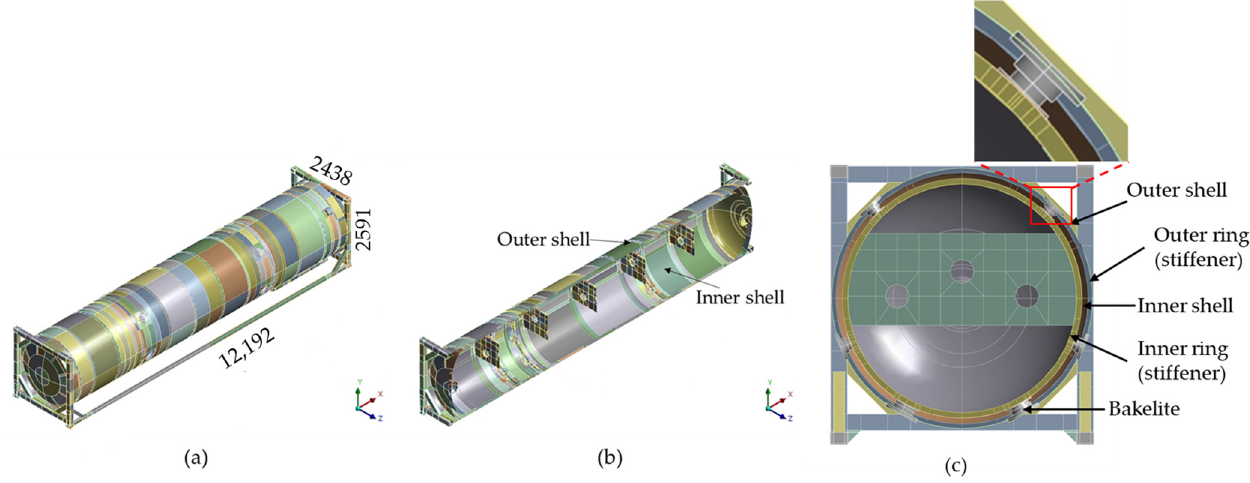
Figure 2. ( a ) Computational domain with dimensions (mm); ( b ) longitudinal section; and ( c ) trans- verse section of the computational domain.